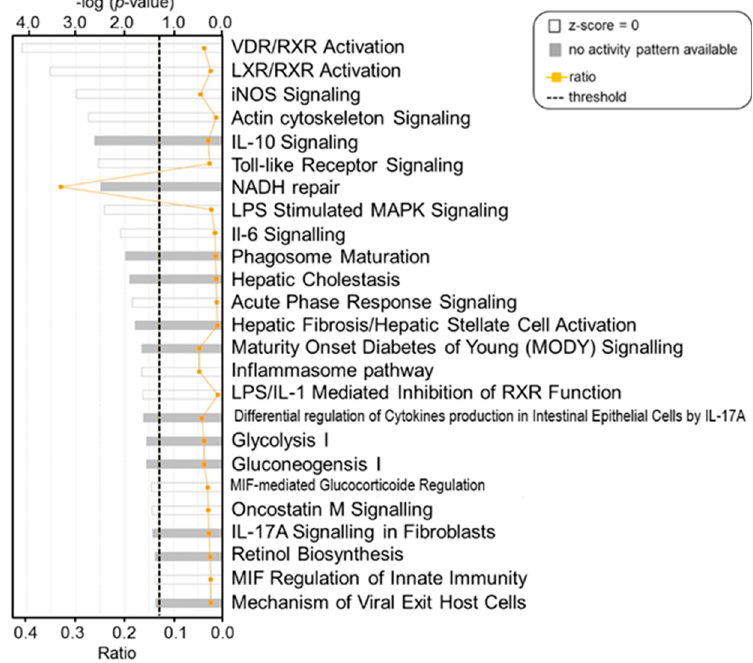
Figure 3. Ingenuity-based identification of key signaling canonical pathways enriched in proteins in milk infected with S. aureus . Each pathway is represented with a bar, the length of which shows the negative log of the p -value obtained by a Right Tailed Fisher’s Exact Test (the longer the bar, the more significant the enrichment) and the color reflects available information on the activity pattern (i.e., protein abundance). White bars: Z-score = 0 indicates protein abundance is enriched in the pathway (i.e., either high-abundant or low-abundant); grey bars: indicate that no activity pattern is available in the software database. Ratio indicates the proportion of differentially abundant proteins found in the current dataset relative to the total number of proteins contributing to that pathway (e.g., a ratio of 0.2 indicates that 20% of the proteins in the pathway were identified in the dataset). VDR/RXR = Vitamin D receptor, RXR = retinoid X receptor, LXR = liver X receptor, RXR = retinoid X receptor, NOS = nitric oxide synthase, IL = interleukin.